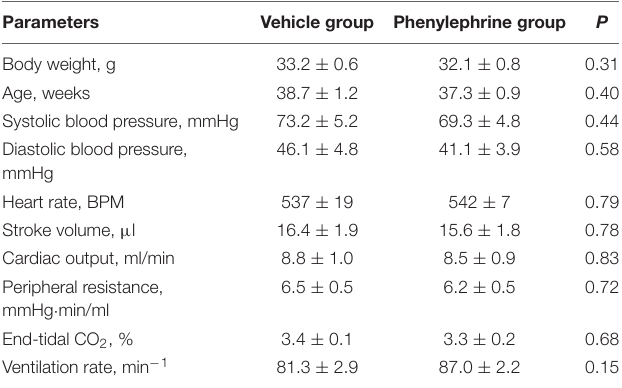
TABLE 1 | Bodyweight, age, and baseline ventilatory, and cardiovascular parameters of anesthetized mice prior to administration of either phenylephrine (0.3 mg/kg, i.p.) or vehicle, and prior to cardiac